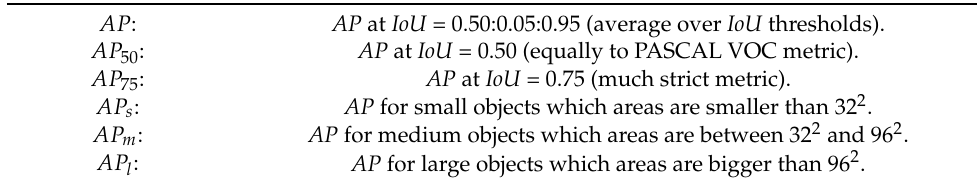
Table 1. The explanations of the COCO metrics.